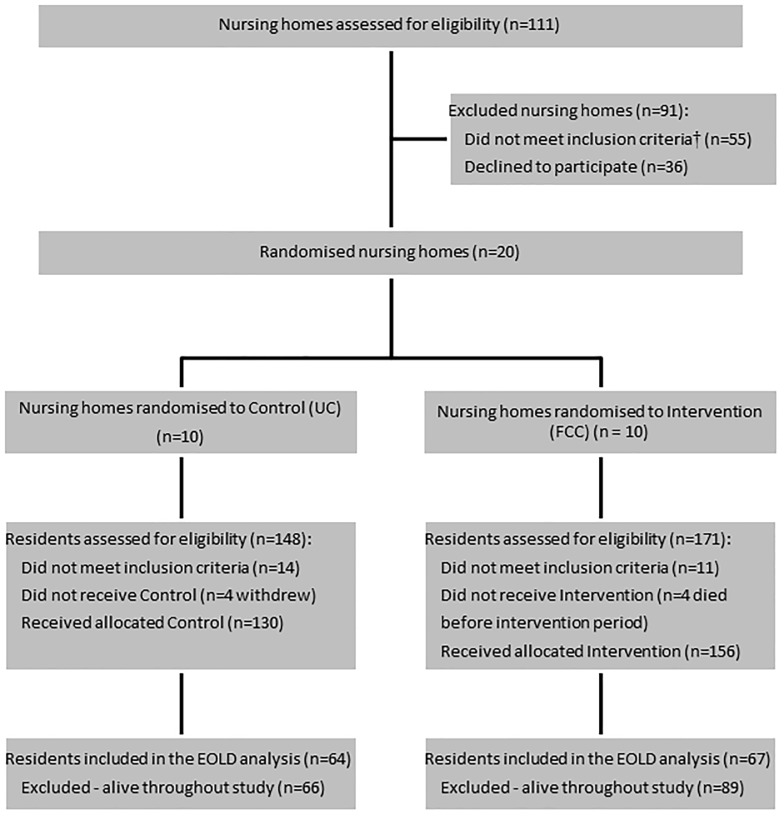
Study flowchart for IDEAL study residents included in EOLD analysis (N = 131).† Original nursing home eligibility criteria were amended, allowing three facilities with bed counts <100 to be included.